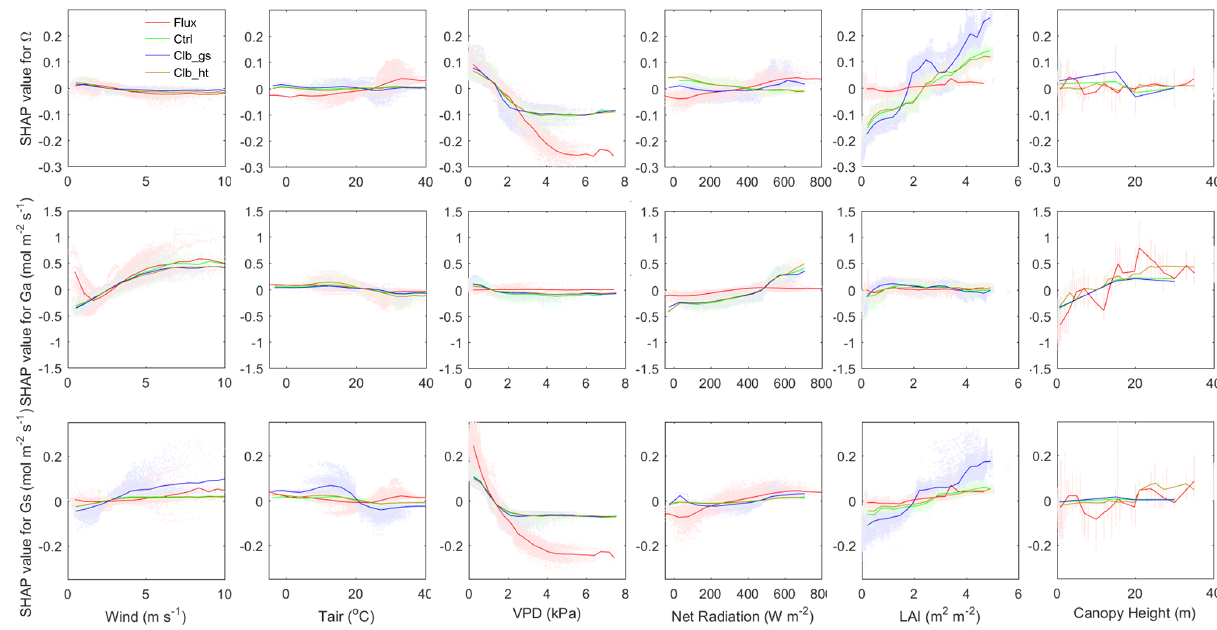
Figure 6. Dependence of (cid:127) (top), Ga (middle) and Gs (bottom) SHAP values on different factors (in order from left to right: wind speed, air temperature, VPD, net radiation, LAI and canopy height). The colors indicate observation or simulations. Red: observation-based dataset, green: Ctrl , blue: Clb_gs , brown: Clb_ht . The shaded dots show the distribution of SHAP values in